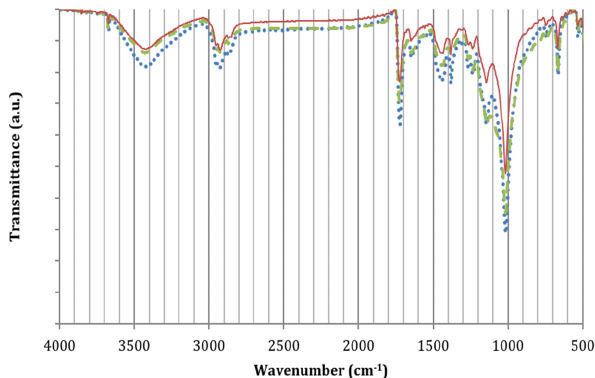
Figure 10. Infrared spectra (4000–400 cm − 1 ) of non ‐ metallic (black) graffiti on granite after accelerated ageing induced by NaCl salt cycles. The dotted blue line of the spectrum corresponds to the beginning of the treatment, the dashed grey line to the 7th cycle and the continuous orange line to the 14th cycle.